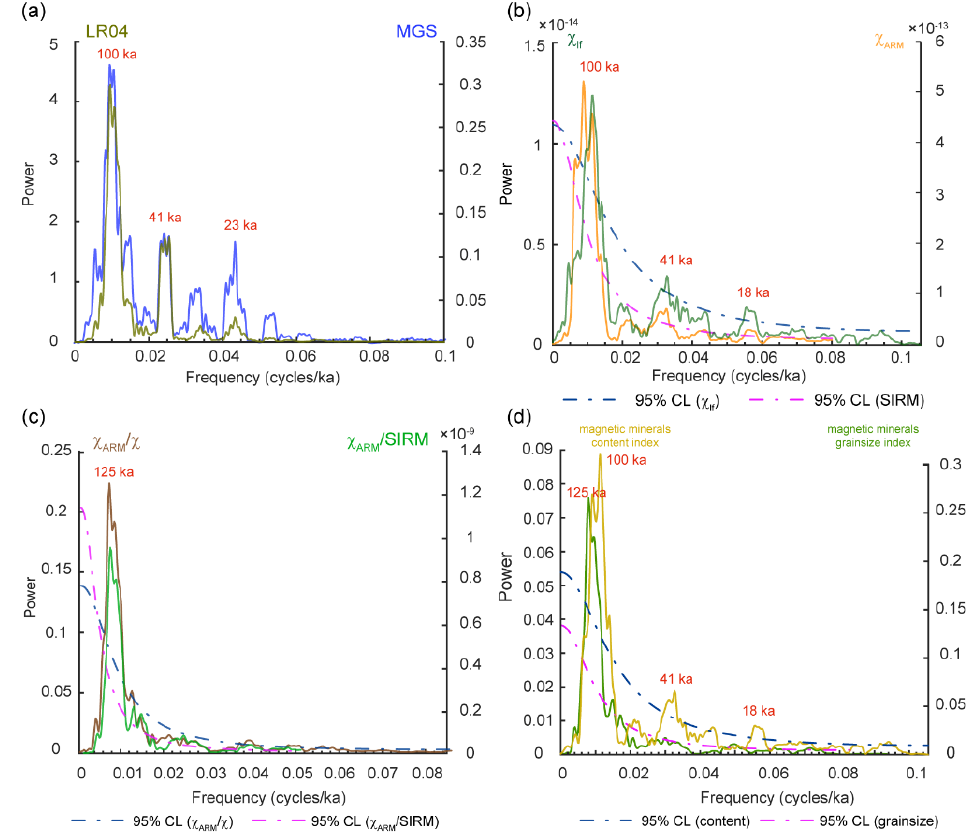
Figure 5. Power spectral calculation by Acycle software [27,28]. ( a ), Benthic δ 18 O stack LR04 [26] and mean grain size of Chinese Loess Plateau [10]; ( b ), χ lf and χ ARM ; ( c ), χ ARM / χ and χ ARM /SIRM; ( d ) magnetic mineral content index and magnetic mineral grain-size index. CL: confidence level.